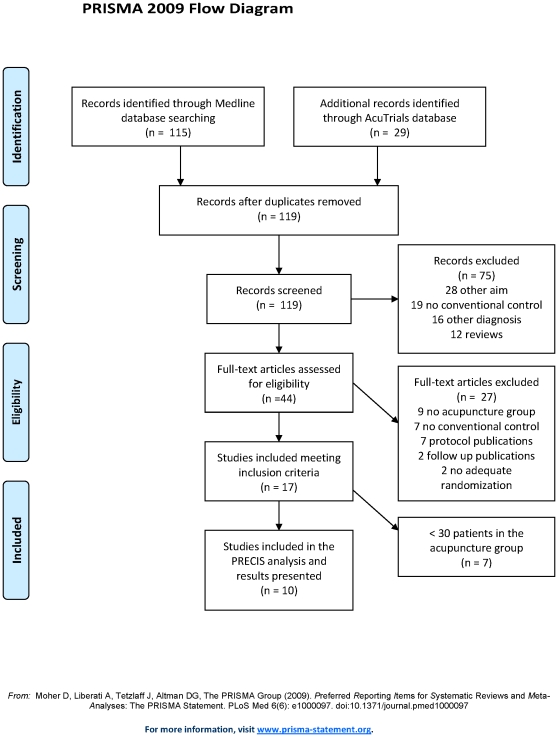
Study selection.